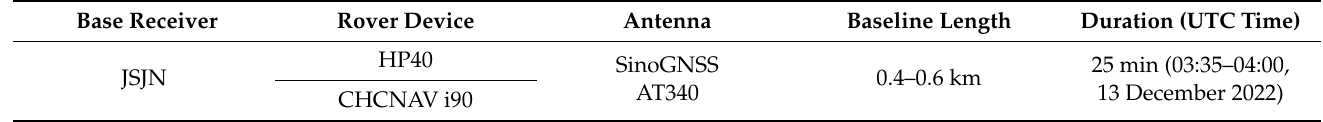
Figure 10. Layout of the smartphone and receiver for collecting kinematic datasets. Table 3. Observation information for kinematic test.